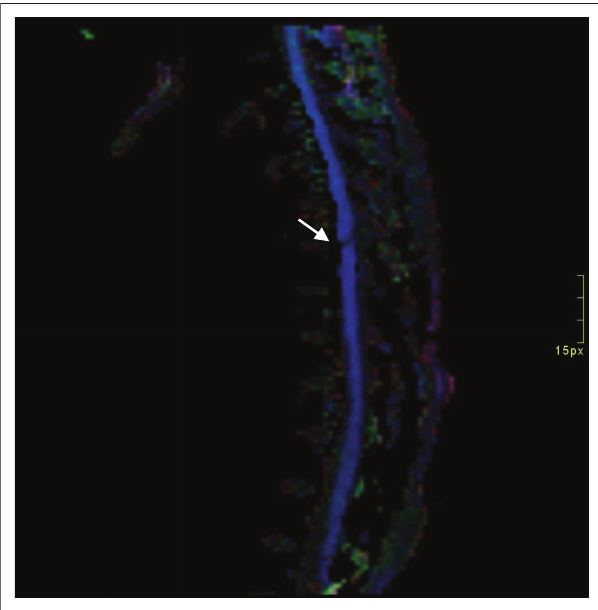
FIGURE 8: Sagittal diffusion tensor imaging of the thoracic spine demonstrates disrupted white matter tracts with decreased fractional anisotropy (arrow).